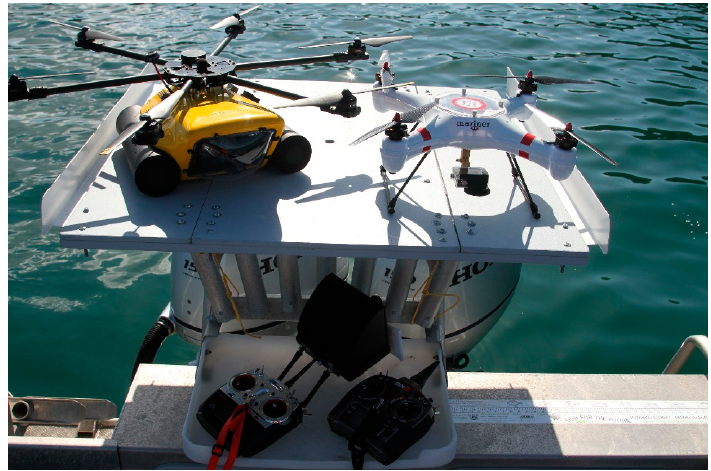
Figure 3. HexH2O™ (XtremeVision360, Worthing, UK) (left) and Splashdrone (SwellPro, Shenzhen, China) (right) on custom built foldable helipad.